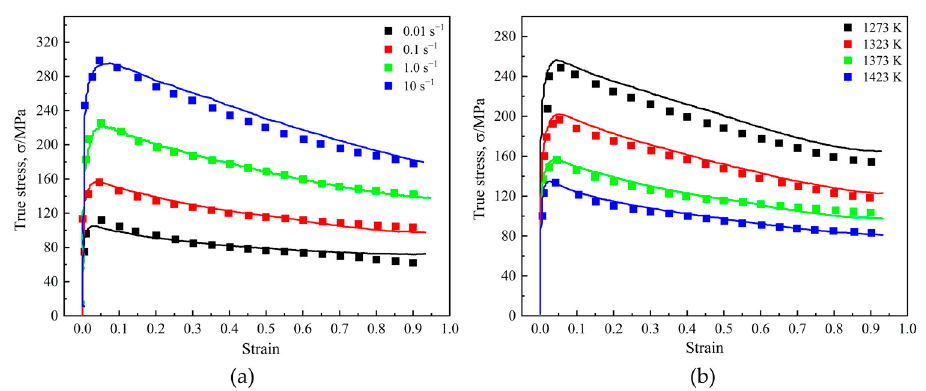
Figure 14. A comparison of flow stress curves of T15MN HSS between the experiment values and predicted ones at ( a ) 0.1 s − 1 and 1273–1423 K; ( b ) 1373 K and 0.01–10 s − 1 .